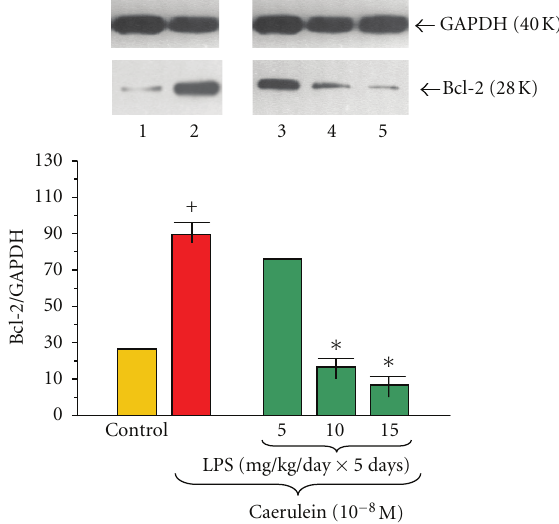
Figure 4: Western blot analysis of Bcl-2 protein level in the adult rat pancreatic acinar cells under basal conditions (lane 1), stimulated in vitro by caerulein at the dose of 10 − 8 M (lane 2), treated in the infant animals by lipopolysaccharide ( Escherichia coli ) at the doses of 5mg/kg/day × 5 days + caerulein 10 − 8 M (lane 3), 10mg/kg/day × 5 days + caerulein 10 − 8 M (lane 4), and 15 mg/kg/day × 5 days + caerulein 10 − 8 M (lane 5) after 5 hours of incubation. Cross indicates significant ( P < 0 . 05) change, as compared to the control group. Asterisk indicates significant ( P < 0 . 05) change, as compared to the value obtained from the rats treated by increasing doses of LPS (10 or 15 mg/kg/day × 5 days) in combination with caerulein (10 − 8 M), as compared to the caerulein (10 − 8 M) alone stimulation. The blots were stripped and probed with GAPDH to document equal protein loading. All presented results were obtained in 4 consecutive experiments and are representative for the observed phenomenon.